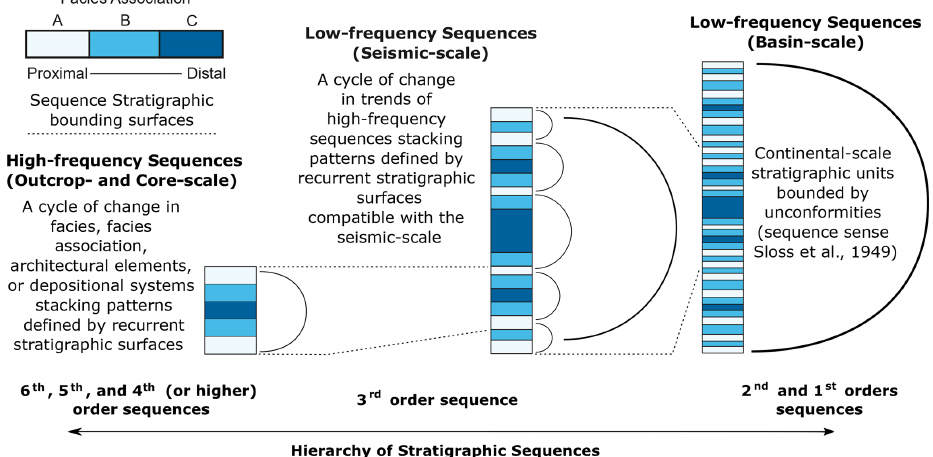
Figure 27. Hierarchical stratigraphic sequence framework (modified from Magalhães et al., 2020). High-frequency sequences (fourth or higher orders) are observed at outcrop and core scale. The vertical recurrence of high-frequency sequences composes the low-frequency sequences observed in seismic data (third order). First- and second-order low-frequency sequences occur at basin scale predominantly limited by unconformities, as proposed by Sloss et al.